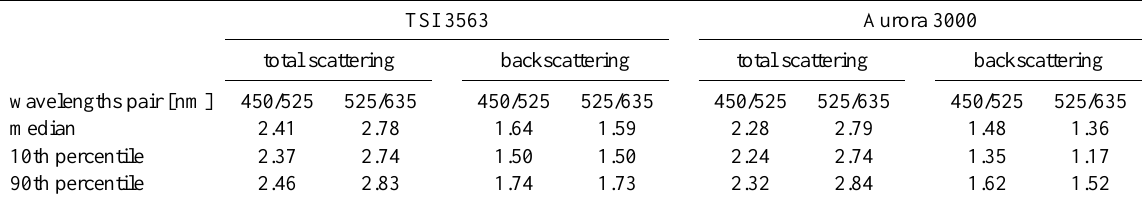
Table 5. ˚Angstr¨om exponents for two wavelength pairs and angular sensitivity corrected total and backscattering, respectively. Given are the median and 10th and 90th percentiles for two wavelength pairs and total and backscattering, respectively. TSI 3563 Aurora 3000 total scattering backscattering total scattering backscattering